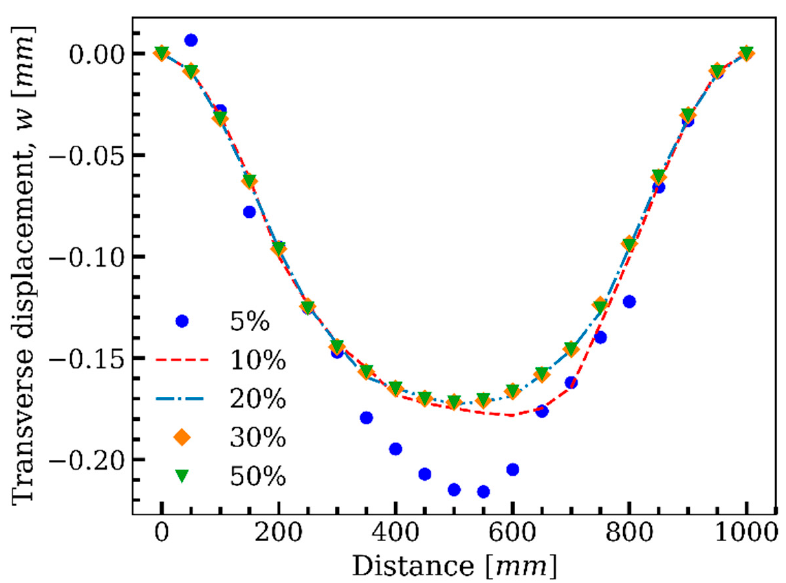
Figure 19. The effect of the ratio of the available sensors to the number of inverse elements on the accuracy of the results.